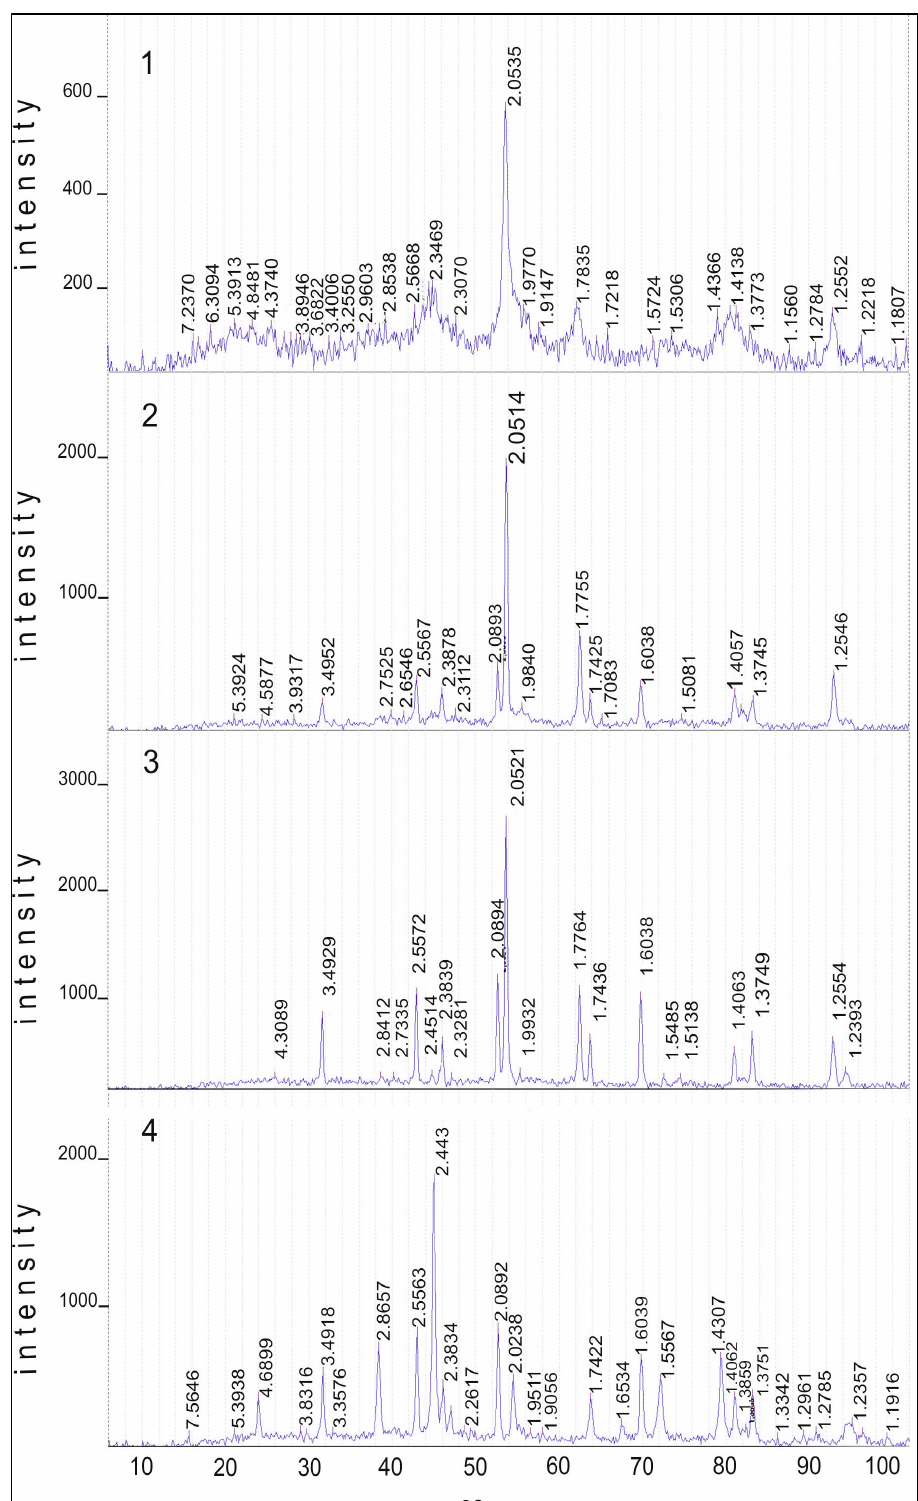
Figure 7. XRD patterns of 10% Co / Al 2 O 3 calcined in air at ( 1 ) 550, ( 2 ) 850, ( 3 ) 1100 ◦ C and then reduced in the thermoprogrammed reduction (TPR) mode up to 1200 ◦ C. Sample ( 4 ) was obtained by oxidation in air at 600 ◦ C, using the sample after TPR.